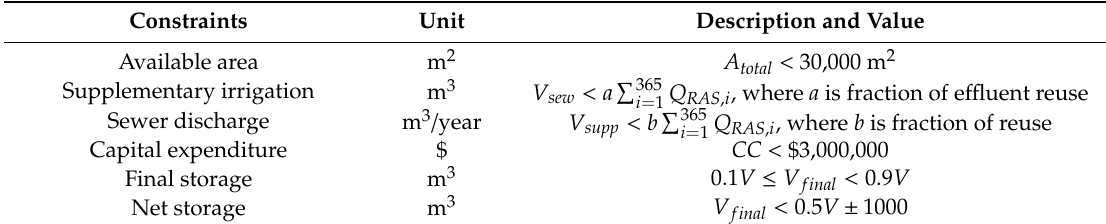
Table 1. Optimization constraints (all $ values in AUD).